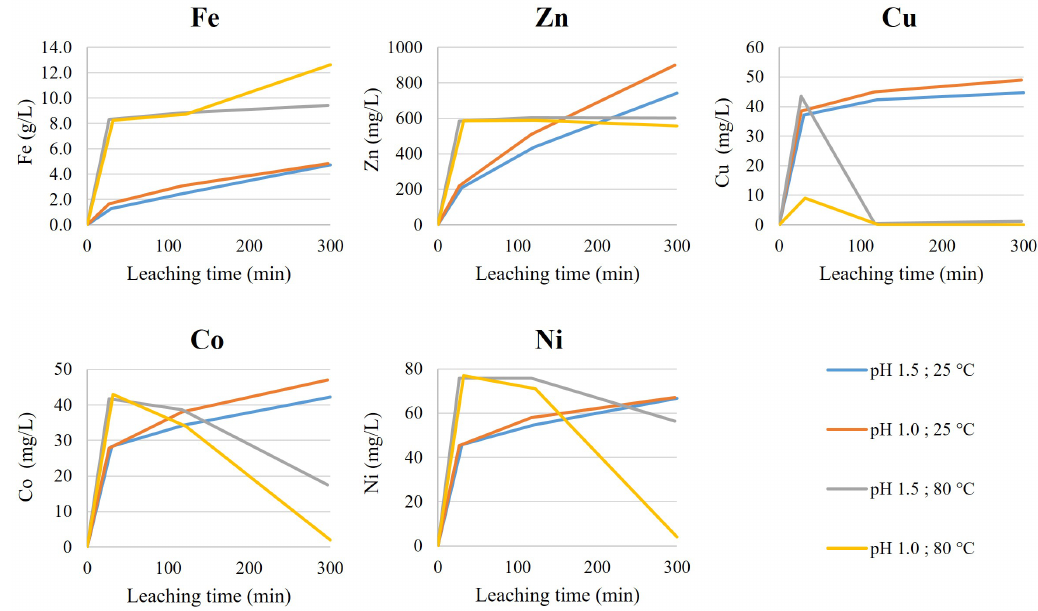
Figure 2. Concentrations of Fe, Zn, Cu, Co and Ni in solution during the leaching.